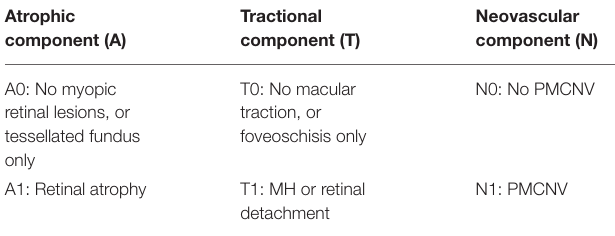
TABLE 1 | Final classification